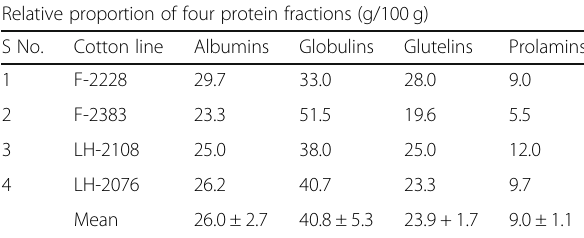
Table 3 Relative proportion of four protein fractions in seeds of cotton lines of G.